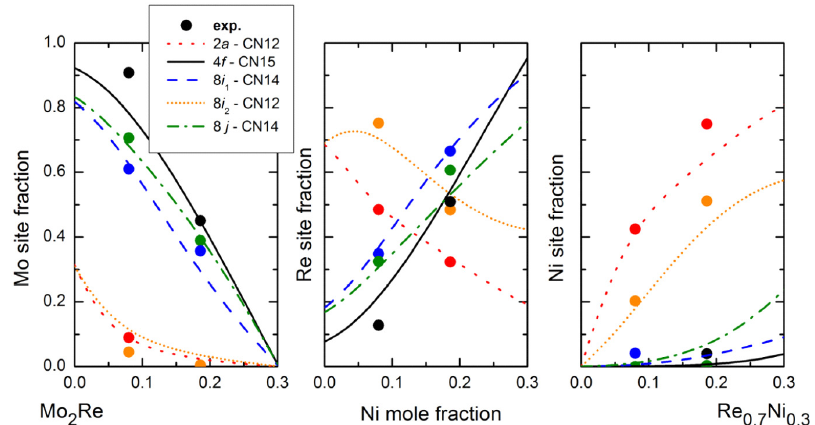
Figure 13. Calculated and experimental site occupancies for the σ phase at 1200 °C